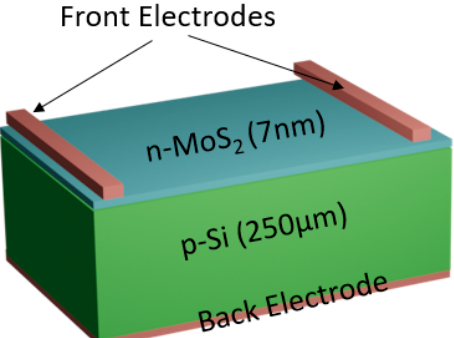
Figure 8 . Simulated n-MoS 2 /Si heterojunction solar cell.